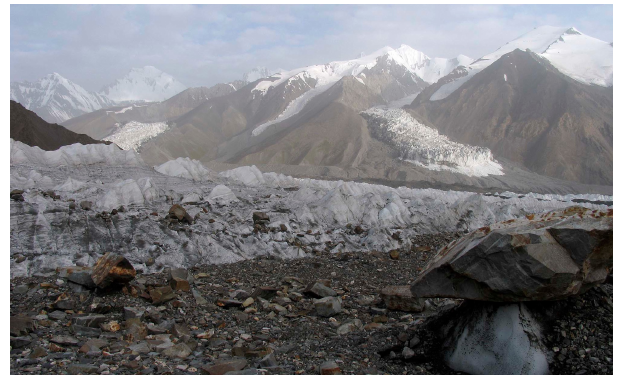
Figure 7. A surging tributary of Sarpo Laggo Glacier can be seen to the right of the centre of the image, as viewed from Moni Glacier in the foreground (see Sect. 3.1.3 for details). To the left of the centre of the image, another unnamed surging glacier is visible. The photo was taken in 2006 by Michael Beck